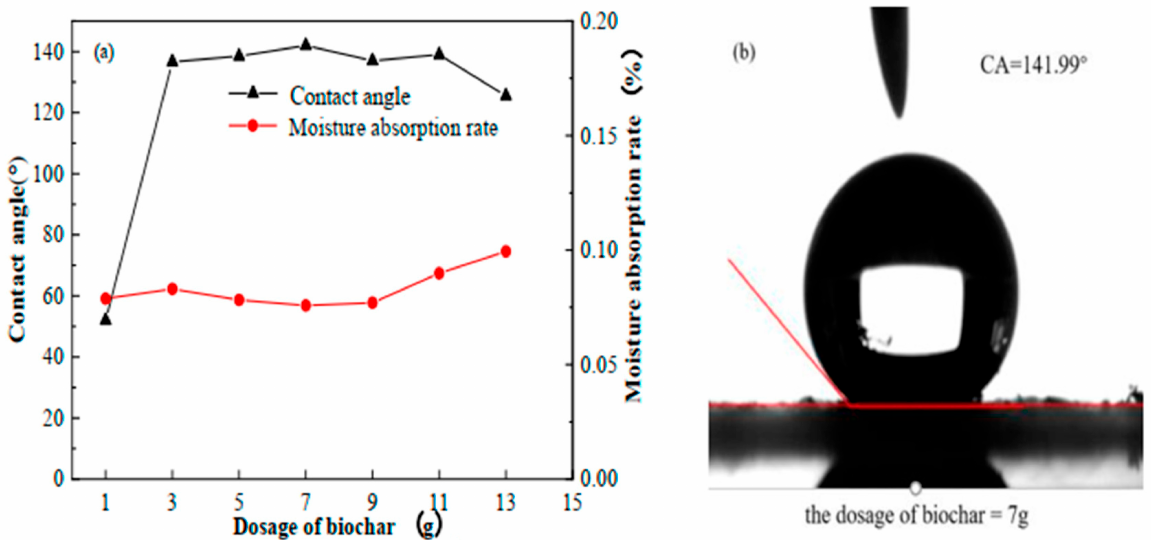
Figure 4. ( a ) Contact angles and moisture absorption rates of modified biochar with different dosage, and ( b ) contact angle of modified biochar when the dosage of biochar was 7